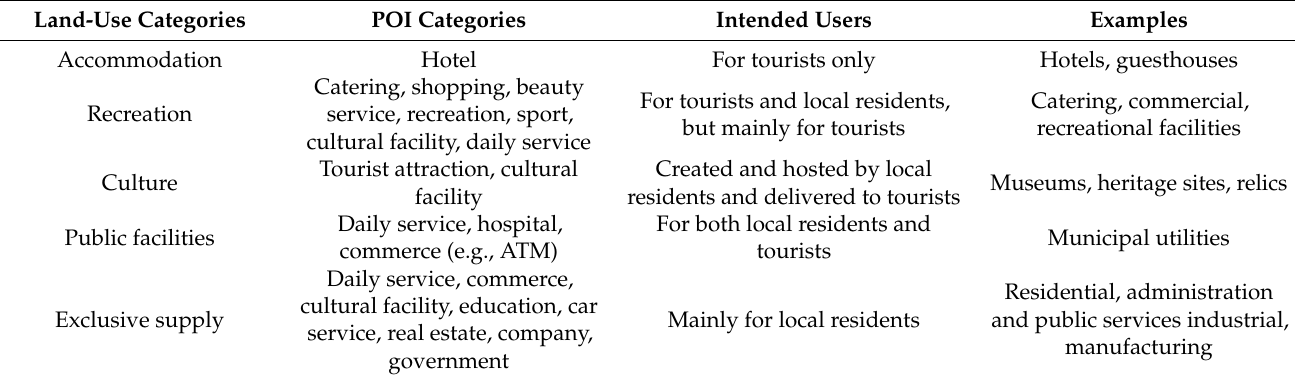
Table 2. The mapping of POI categories in the